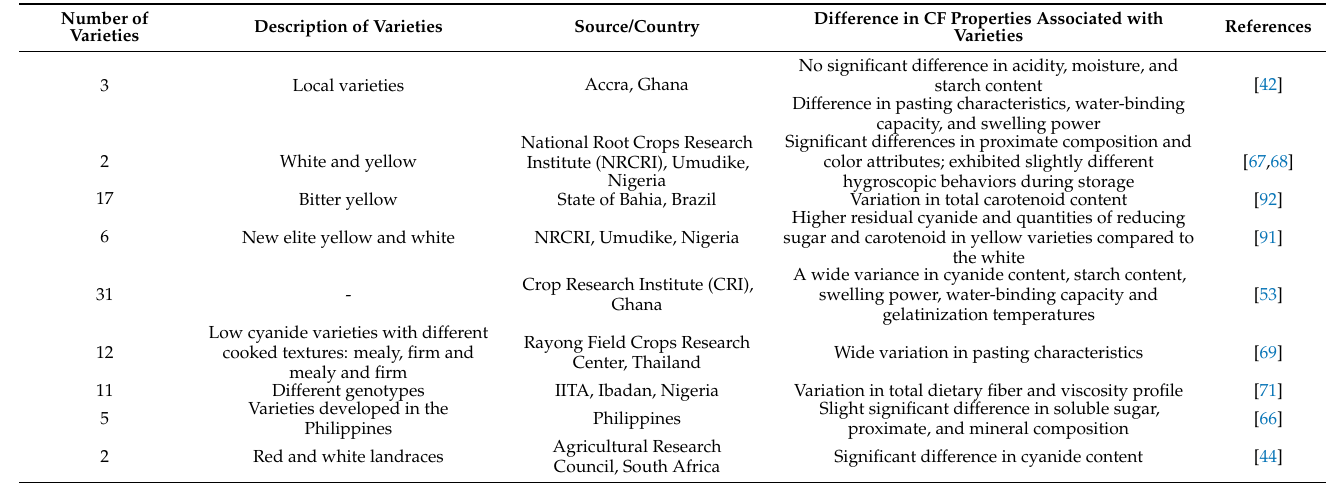
Table 3. Studies on varietal differences in cassava flour